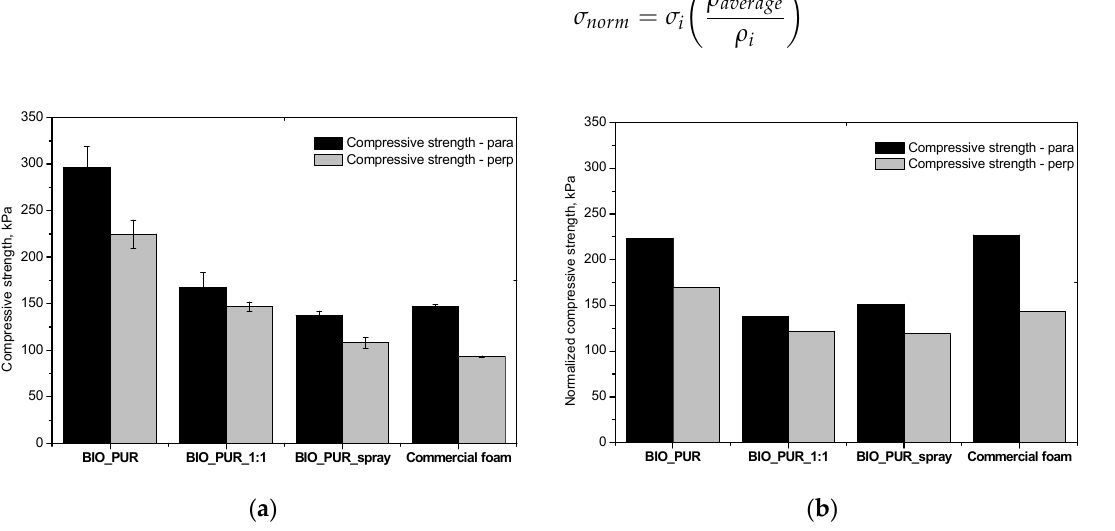
Figure 4. The compressive strength ( a ) and normalized compressive strength ( b ) of spray PUR bio-foams obtained in laboratory and industrial conditions. Scale measured in two directions: perpendicular and parallel to the foam rise direction.